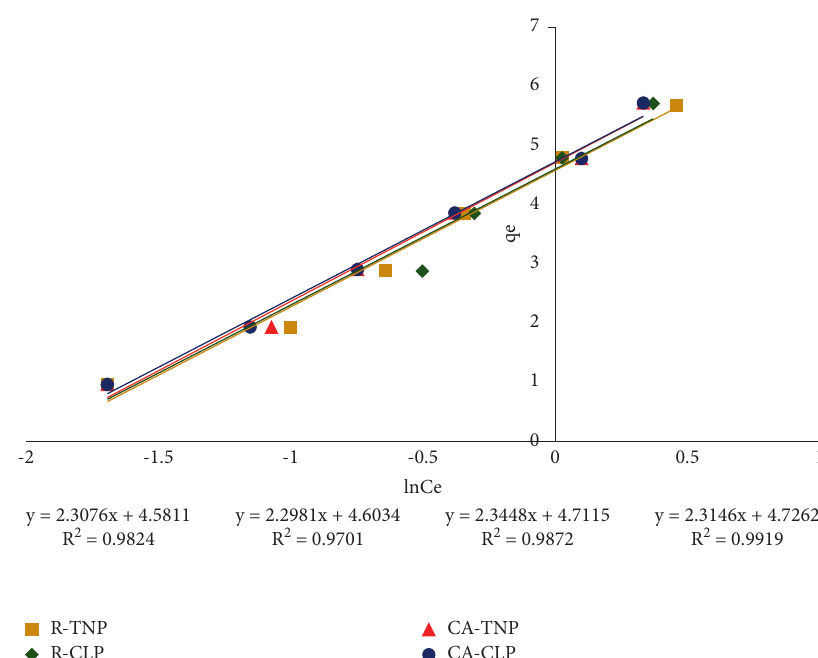
Figure 14: Comparison of effective parameters of Temkin isotherm for the adsorption of BGD. Adsorbent dose � 0.5g, contact time- � 25min, temperature � 30 ° C, agitation speed � 100rpm, initial pH � 5, final pH: R-TNP � 5, R-CLP � 4.5, CA-TNP � 4.0, and CA- CLP � 4.0, and dye solution volume V � 100 mL.